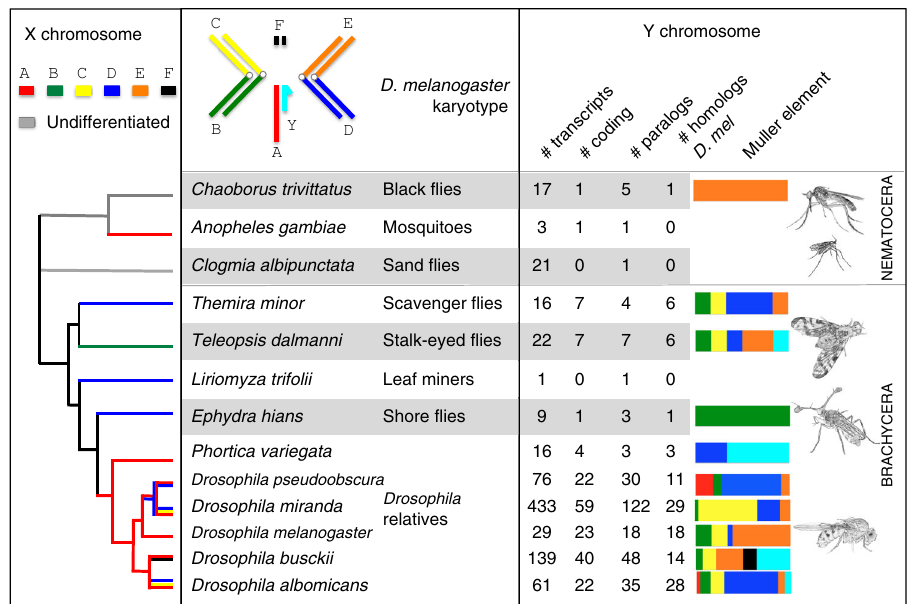
Fig. 3 Y gene content evolution in fl ies. Shown are the species for which we have identi fi ed Y-linked transcripts. The karyotype of D. melanogaster males is shown (consisting of Muller element ’ s A-F), and the color-coded branches of the phylogeny indicate which chromosome arm (Muller element) segregates as the sex chromosome in a species (from ref. 9 ). The table gives the number of Y-linked transcripts identi fi ed from each species (#transcripts), the number of Y-linked transcripts that are predicted to be protein-coding (#coding), the number of Y-linked transcripts for which we could detect a paralog within the female genome of a particular species (#paralogs), and the number of Y-linked transcripts for which we could detect a homolog in D. melanogaster (#homologs D. mel ). The bar charts indicate to which Muller element Y-linked homologs match within the D. melanogaster genome (with Y-linked genes of D. melanogaster being shown in turquoise); for D. melanogaster , mapping of Y-linked paralogs within the female D. melanogaster genome is shown. Shading distinguishes between different Diptera families (indicated by the common name of that family). Images drawn by Doris Bachtrog 9